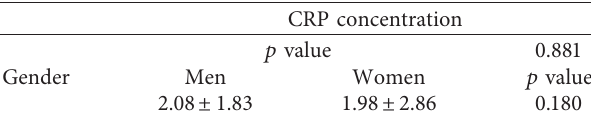
Table 4: Association of age with CRP concentration. CRP concentration β − 0.084 Age p value 0.452 F � 12.221, p � 0 . 000, R 2 � 0.449, adj R 2 � 0.412, DW � 1.85 Multiple regression analysis.